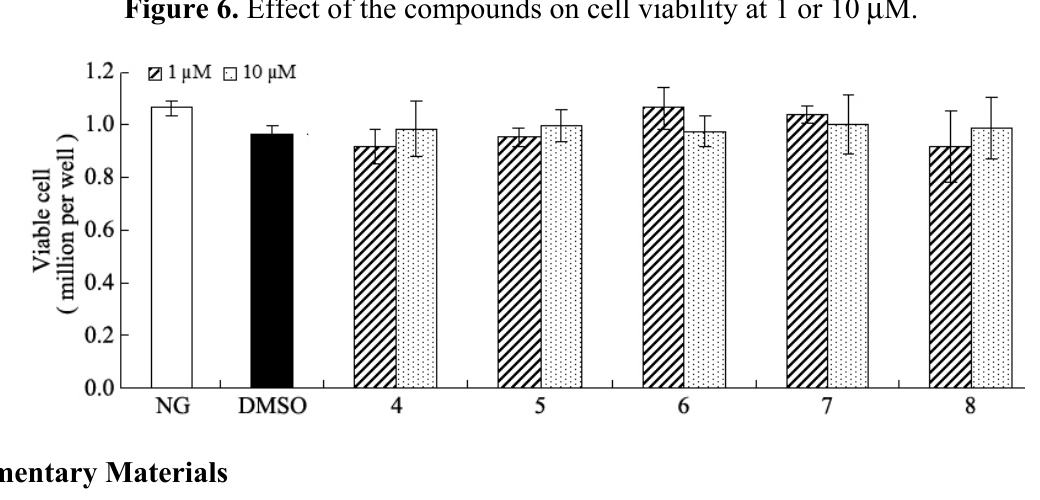
Figure 6. Effect of the compounds on cell viability at 1 or 10 μ